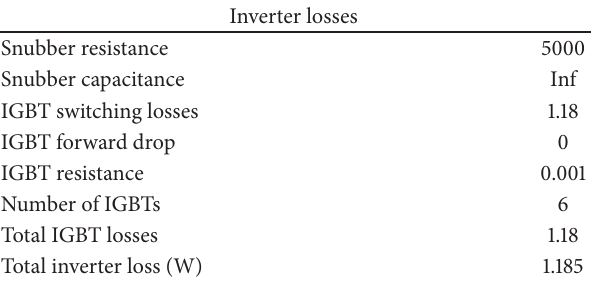
Table 8: Power losses in the inverter.